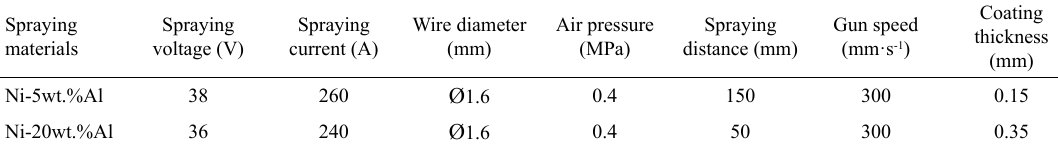
Table 5. Processing parameters of twin-wire arc spraying technique.